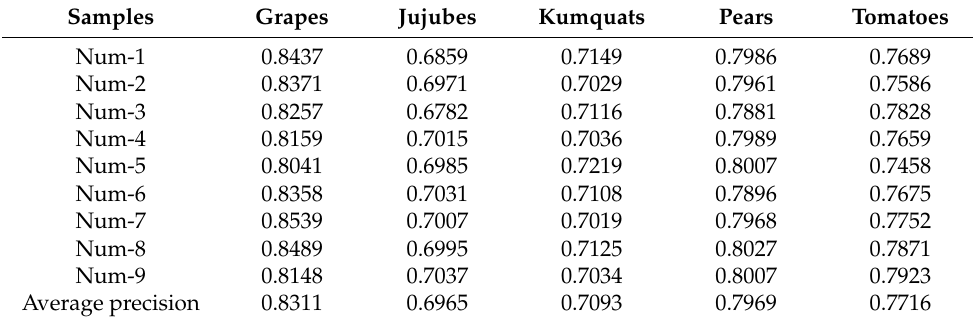
Table 7. Testing five samples with